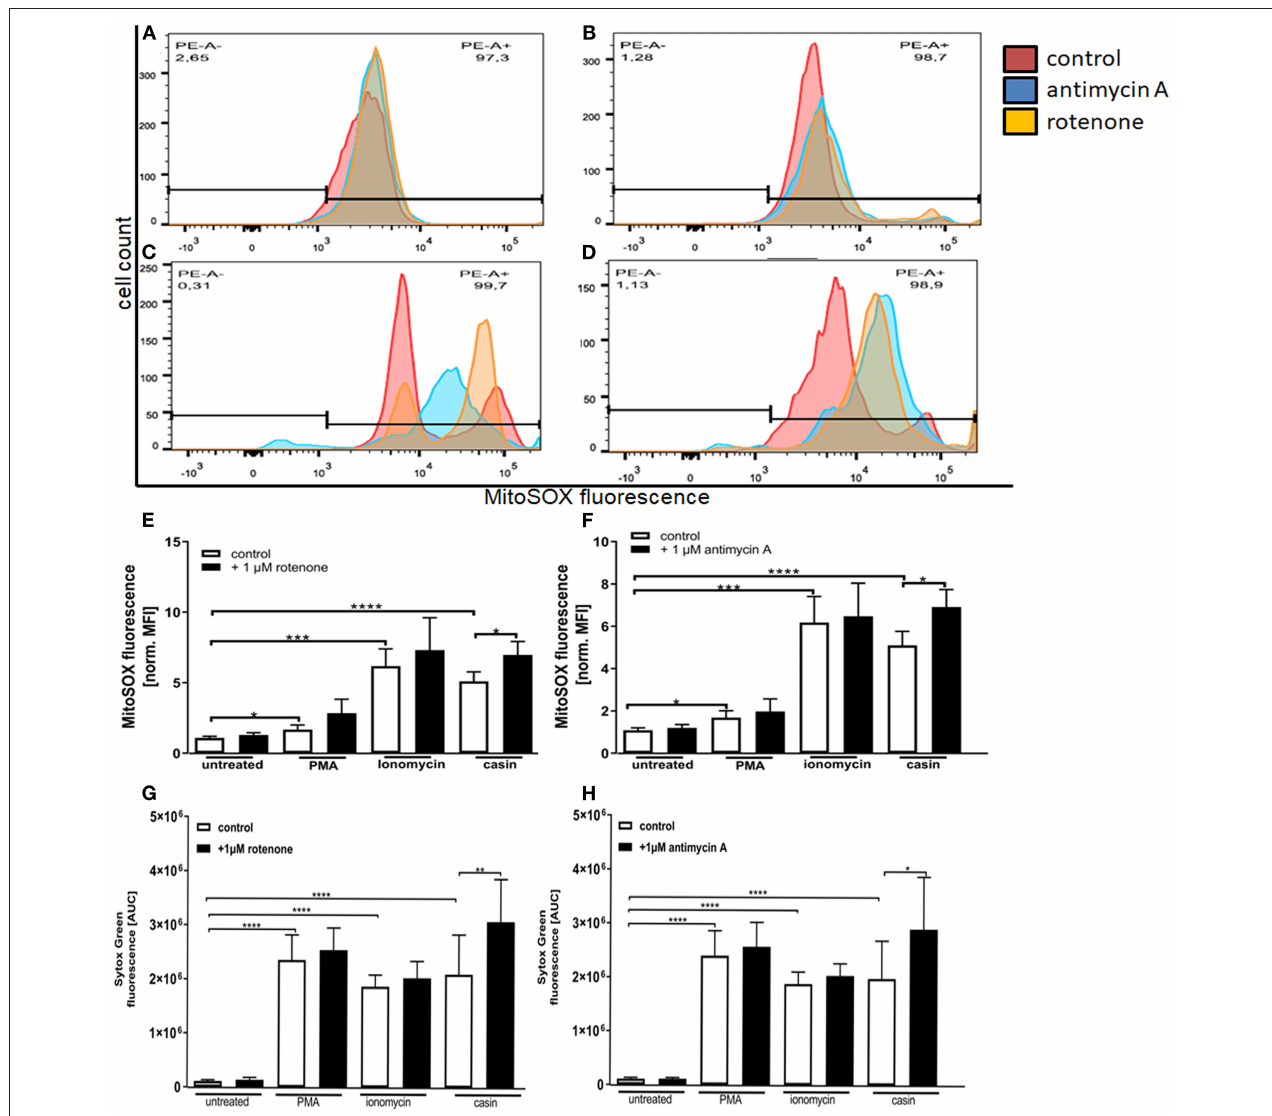
FIGURE 5 | Inhibition of mitochondrial respiratory chain complexes I and III increase the production of mitochondrial ROS which is related to NET formation. Freshly isolated primary human neutrophils were left untreated or pre-incubated with 1 µ M antimycin A (A–D,F) or 1 µ M rotenone (A–D,E) for 30min at 37 ◦ C. Subsequently, cells were incubated with 5 µ M MitoSOX for 20min at 37 ◦ C. Cells were either left unstimulated or stimulated with PMA (20nM), ionomycin (10 µ M) or the Cdc42 inhibitor casin (10 µ M) for 1h at 37 ◦ C. The fluorescence signal of MitoSOX was analyzed using flow cytometry. Displayed are representative histograms showing the MitoSOX fluorescence of control cells (A) and cells stimulated with PMA (B) , ionomycin (C), or the Cdc42 inhibitor casin (D ). (E,F) Quantification of MitoSOX mean fluorescence (MFI) normalized to the MitoSOX MFI of untreated cells. Data show mean ± SD of 4 independent experiments. **** p ≤ 0.0001, *** p ≤ 0.001, ** p ≤ 0.01, and * p ≤ 0.05. Freshly isolated human neutrophils were pre-incubated with or without 1 µ M rotenone (G) or 1 µ M antimycin A (H) for 30min at 37 ◦ C, followed by incubation with or without the mitochondrial ROS indicator MitoSOX (5 µ M) for 20min at 37 ◦ C. The formation of NETs without stimulation (untreated), with 20nM PMA, 10 µ M ionomycin or with the Cdc42 inhibitor casin (10 µ M) was detected over a period of 4h at 37 ◦ C by measuring the fluorescence of DNA bound Sytox Green. Quantification of NET release by calculating the area under the curve (AUC) from Sytox Green kinetic curves. Data show mean ± SD of 3 independent experiments. **** p ≤ 0.0001, ** p ≤ 0.01, and * p ≤